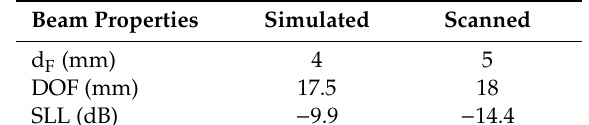
Table 4. Comparison of simulated and scanned acoustic beam properties obtained using a configuration of 445 kHz transducer with a 144° Epoxy/PDMS lens, through the phantom of 5 mm thickness, separated 2 mm from the lens.